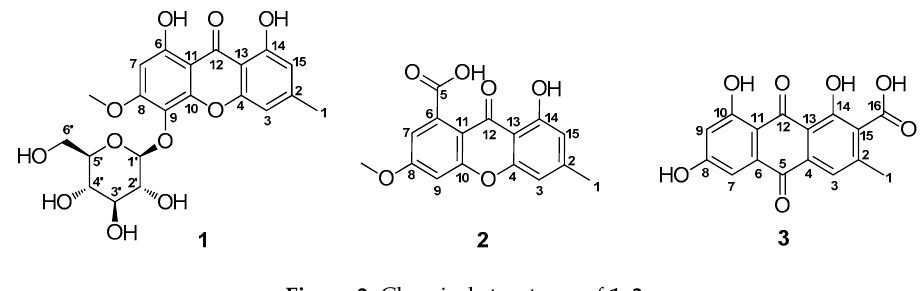
Figure 2. Chemical structures of 1 – 3. Table 1. The 1 H-NMR (400 MHz) and 13 C-NMR (100 MHz) data of compound 1 (in DMSO- d 6 ).